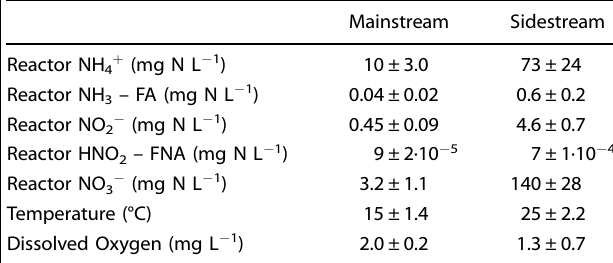
Table 1. Conditions in the MBBRs during the period of